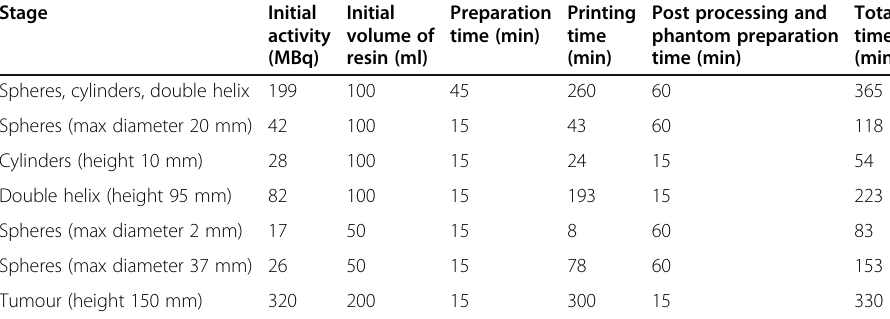
Table 1 Time required to create each phantom and the initial activity required to image approximately 200 kBq/ml Stage